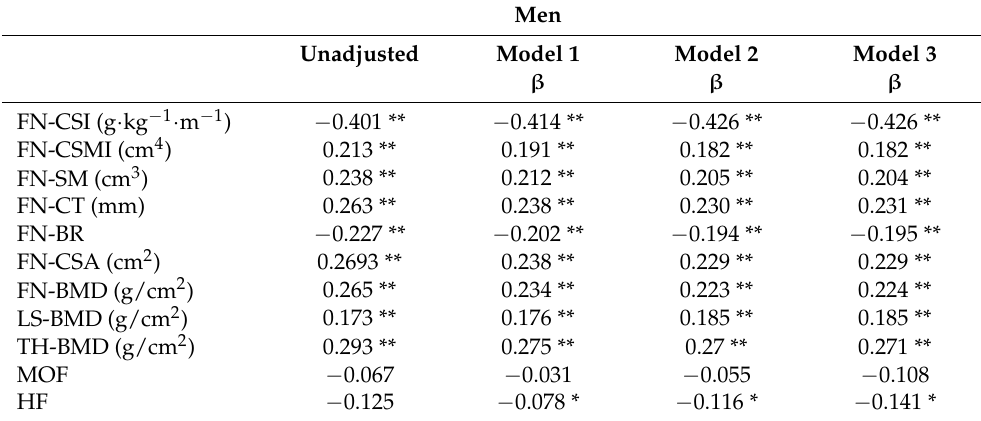
Table 3. Linear regression analysis between the TyG-BMI and the densitometry parameters.